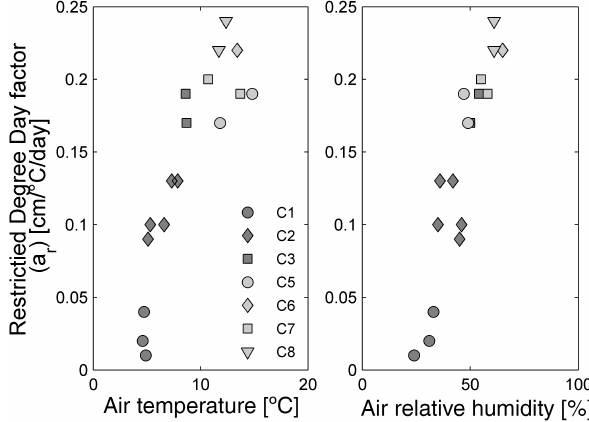
Figure 12. Restricted degree-day factor as a function of space (basin cluster) and climatological properties. Bowen ( β ) coefficient shown between parentheses in the